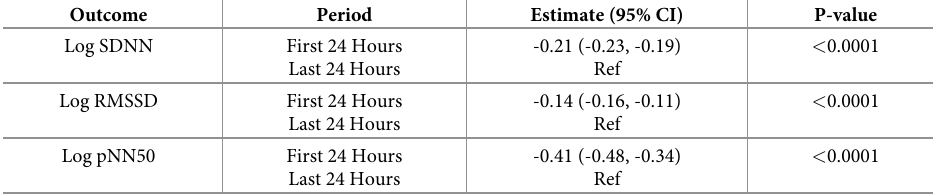
Table 2. Mixed models evaluating log of the three heart rate variability metrics in the first compared to the last 24 hours of PICU stay. Outcome Period